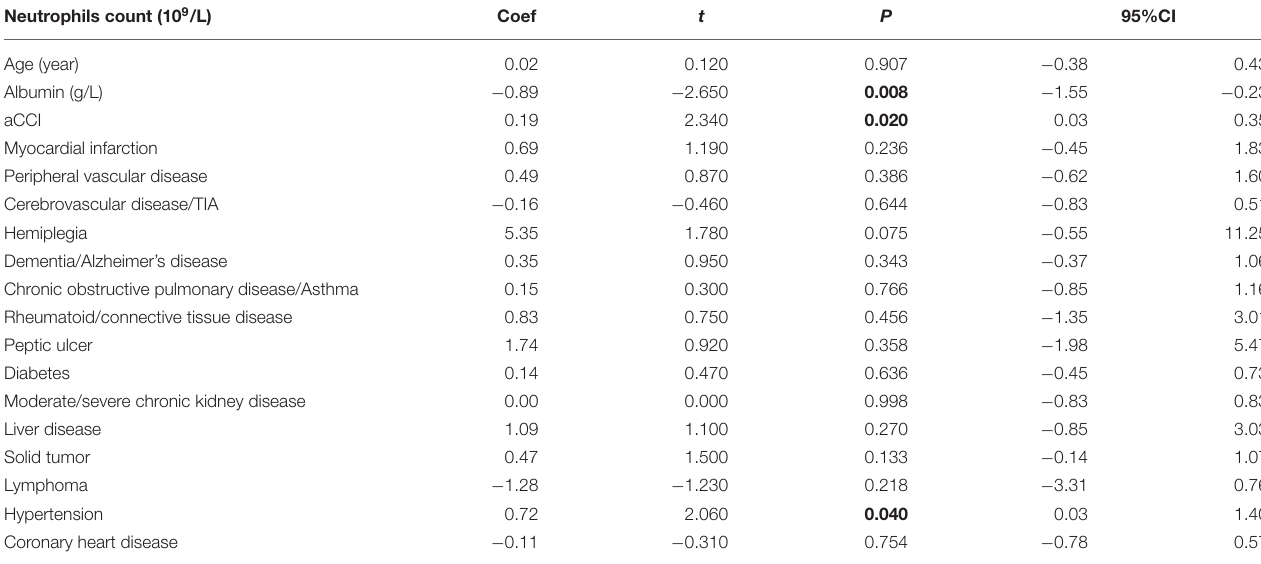
TABLE 3 | Correlation of age-related risk factors (age, nutrition, and comorbidities) in Neutrophils count in all infected patients. Neutrophils count (10 9 /L)